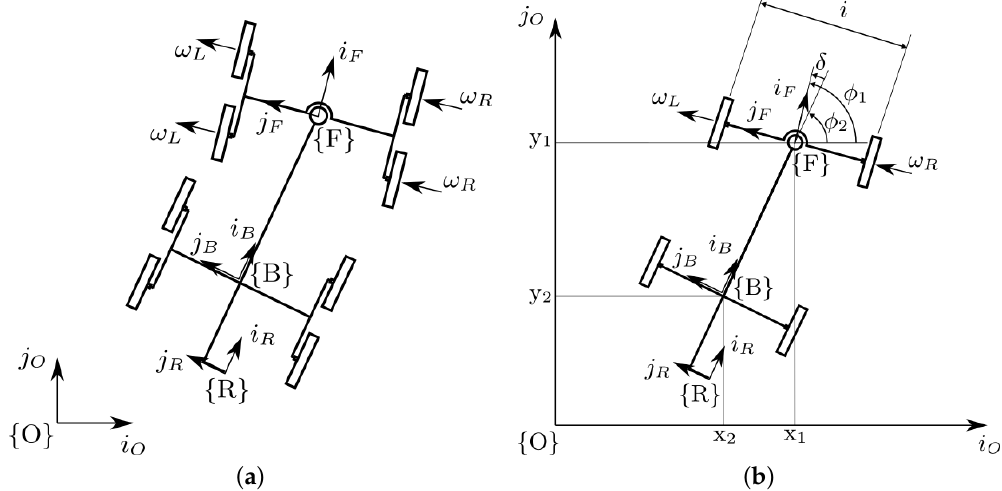
Figure 3. ( a ) Model of Agri.Q articulated mobile base on { ˆ i O , ˆ j O } plane. The system is described by the position and orientation of the three mobile reference frames, where { F } is the front module r.f., { B } is the back module r.f., and { R } refers to the manipulator. In ( b ) the reduction of each couple of wheels to a single one is represented.